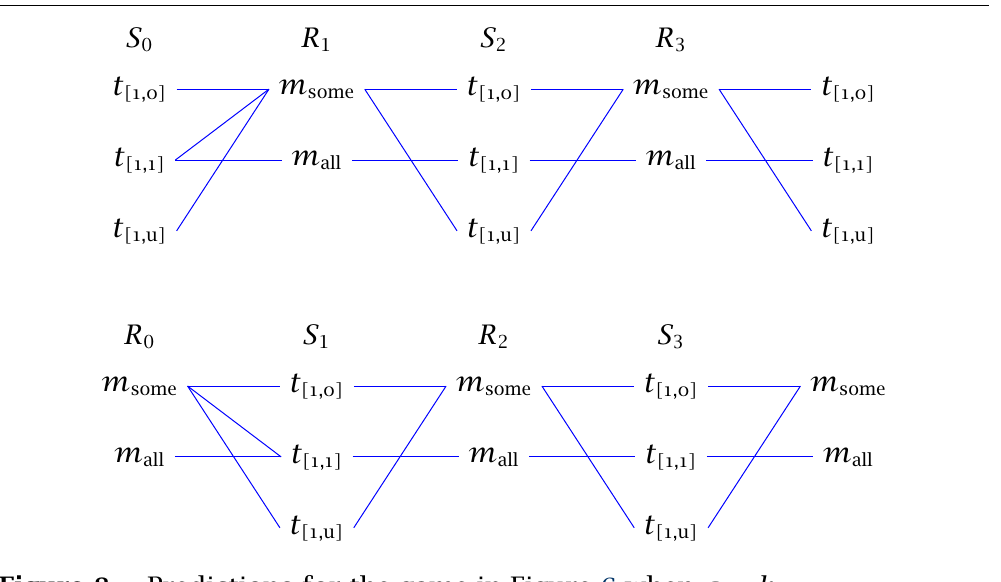
Figure 8 Predictions for the game in Figure 6 when a =